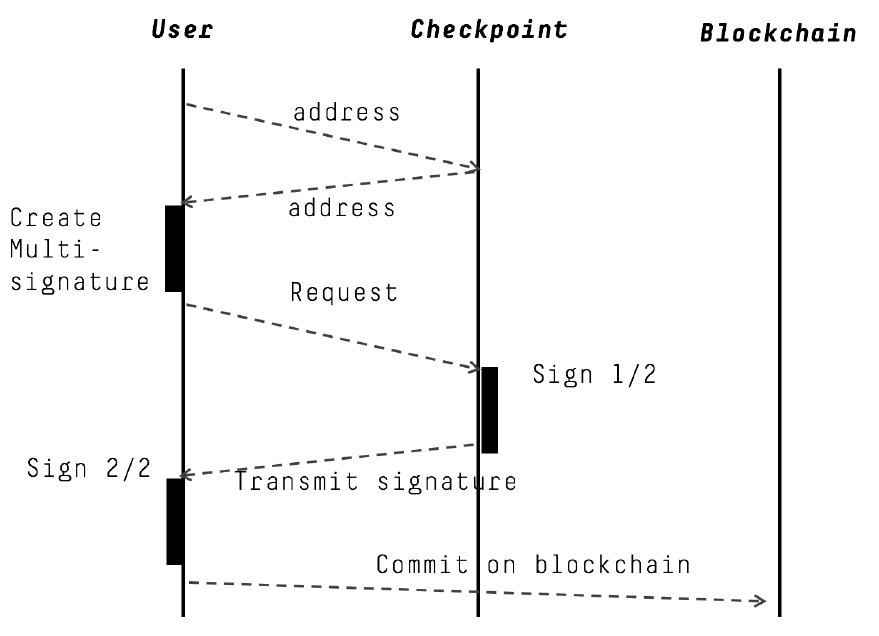
Figure 4. Multi-signature flow